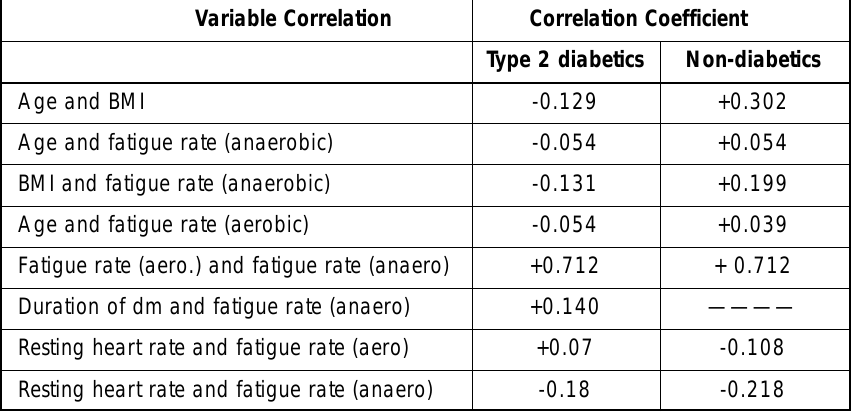
Table 4: Correlation Coefficients between Fatigue Time and some Clinical Features Variable Correlation